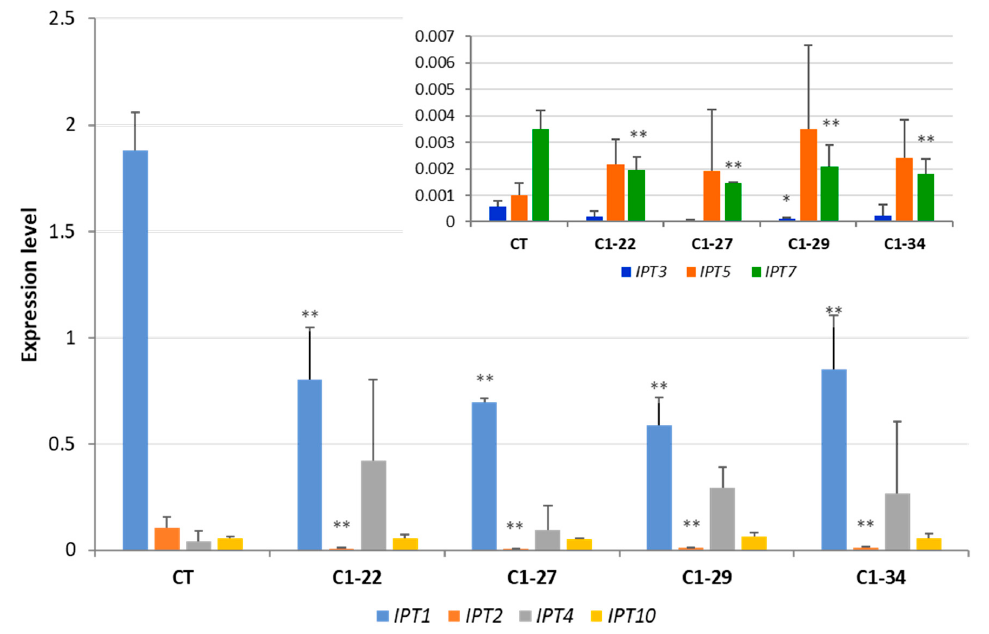
Figure 5. Expression levels of HvIPT genes in seven DAP spikes of ckx1 mutant lines; the expression of HvIPT3 , HvIPT5 and HvIPT7 was shown on a separate graph because of lower expression level. CT, control plants; values are mean ± SD (Table S8) significantly different from the control at * p < 0.05, ** p < 0.01. The expression levels were calculated from three technical replicates according to the standard curve methods using the Elongation factor 2 gene as a normalizer. The analysis was performed for three biological replicates.